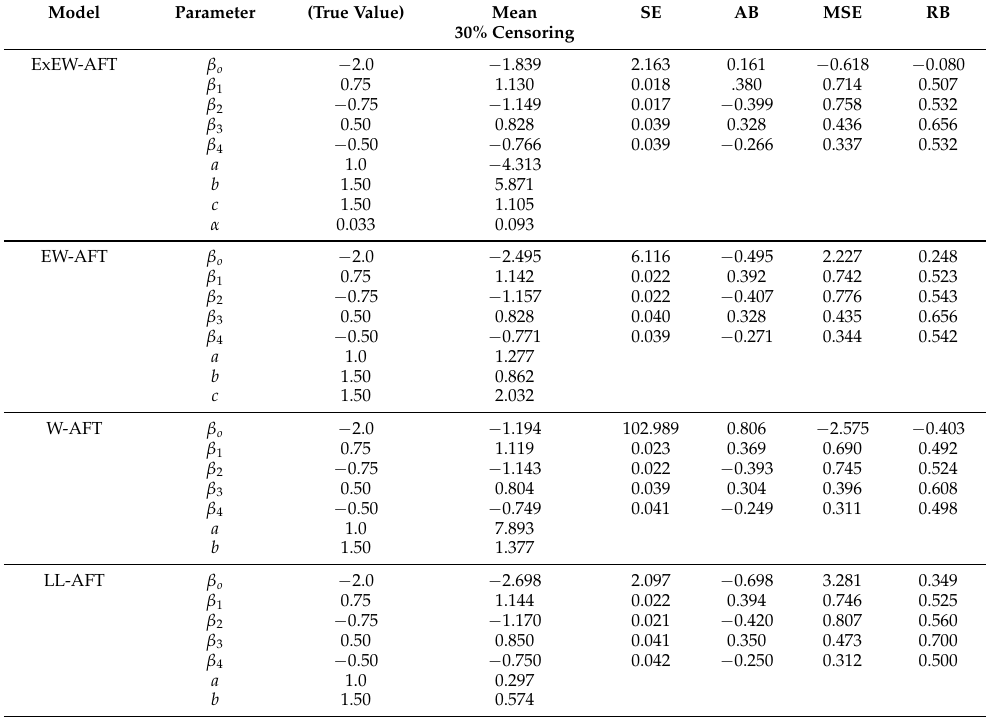
Table 4. Simulation study for scenario 1 ( n = 5000) with about 30% censored observations is used to compare model